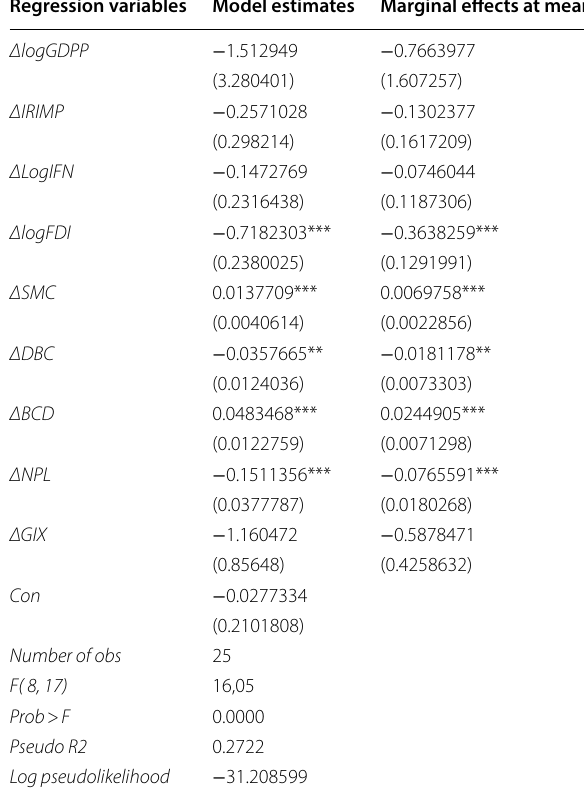
***, ** and * represents 1%, 5% and 10% level of significance respectively